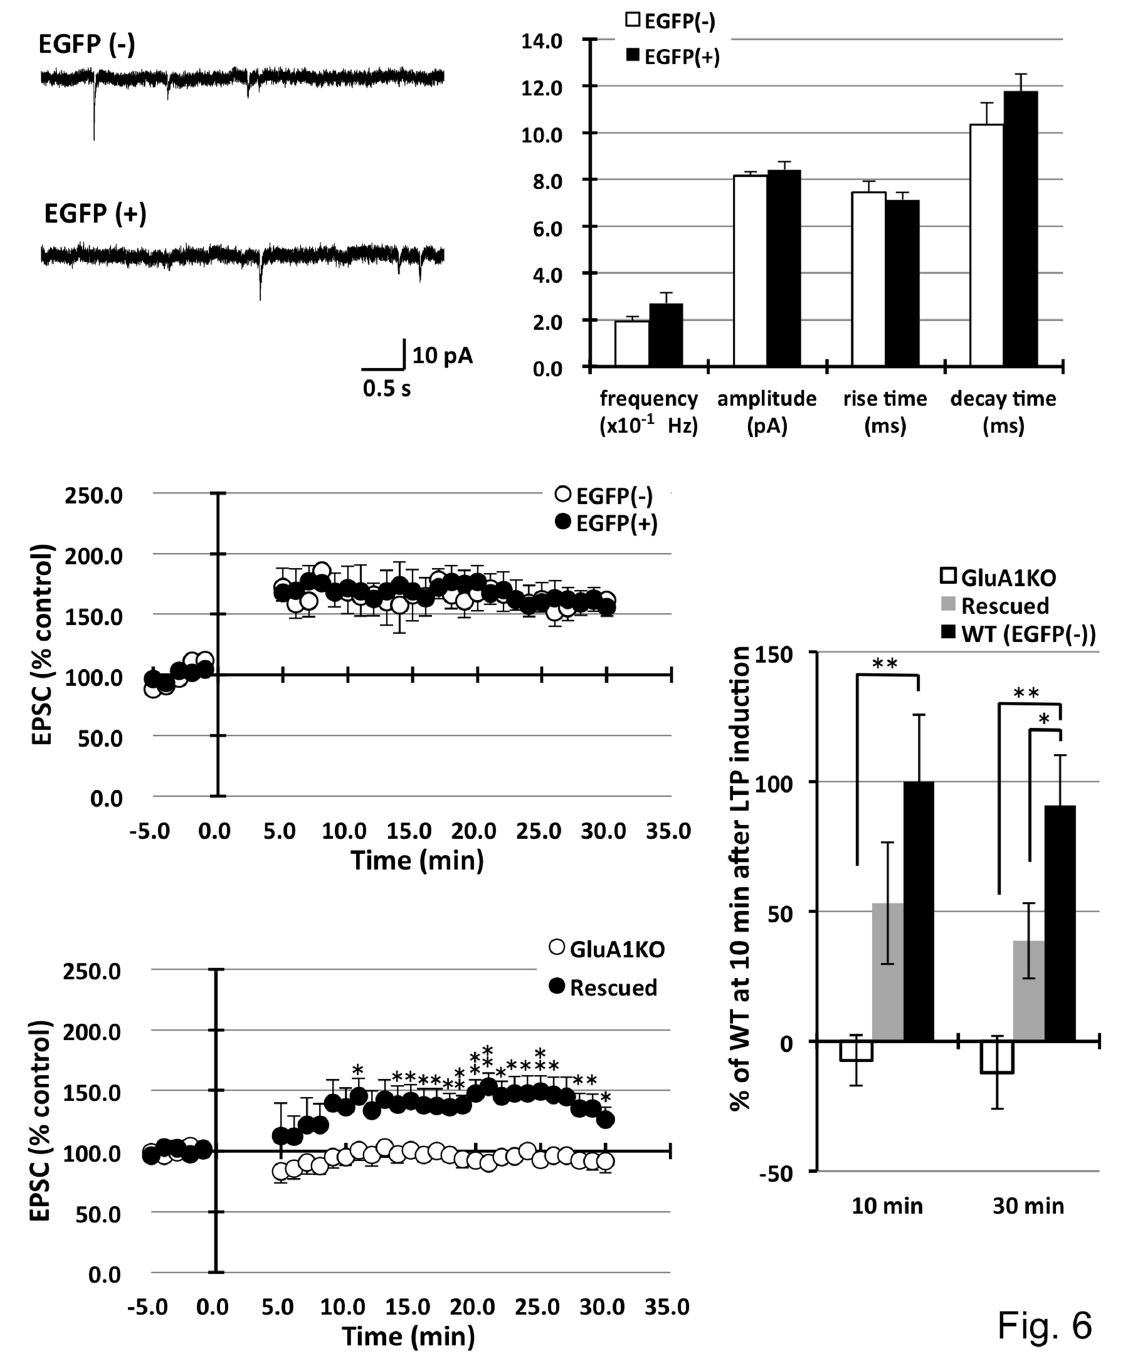
Figure 6. Electrophysiological analysis of lentivirus-infected neurons. EGFP-expressing lentivirus vectors were stereotaxically injected into the CA1 pyramidal neurons, and patch clamp analyses were carried out on infected and non-infected neurons. A . B . Analysis of the mEPSCs showed comparable frequency, amplitude, and decay time compared to the non-infected neurons. Non-infected cells: EGFP(-) n=7, infected cells: EGFP(+) n=8, C . Pairing-induced LTP was not significantly different between the two types of neurons. EGFP(-) n=6, EGFP(+) n=7. D . The injection of ZsGreen lentivirus vector expressing GluA1 into hippocampus CA1 had partially rescued LTP in GluA1 knockout mice. (* P<0 . 05 , ** P<0.01 ) E . Statistical analysis of LTP in wild (EGFP (-)), rescued, and GluA1 knockout mice in 10 min and 30 min after LTP induction. LTP was partially rescued by GluA1- expressing lentivirus infection in GluA1 knockout mouse. (* P<0 . 05 , ** P<0.01 ). doi: 10.1371/journal.pone.0083129.g006 PLOS ONE |